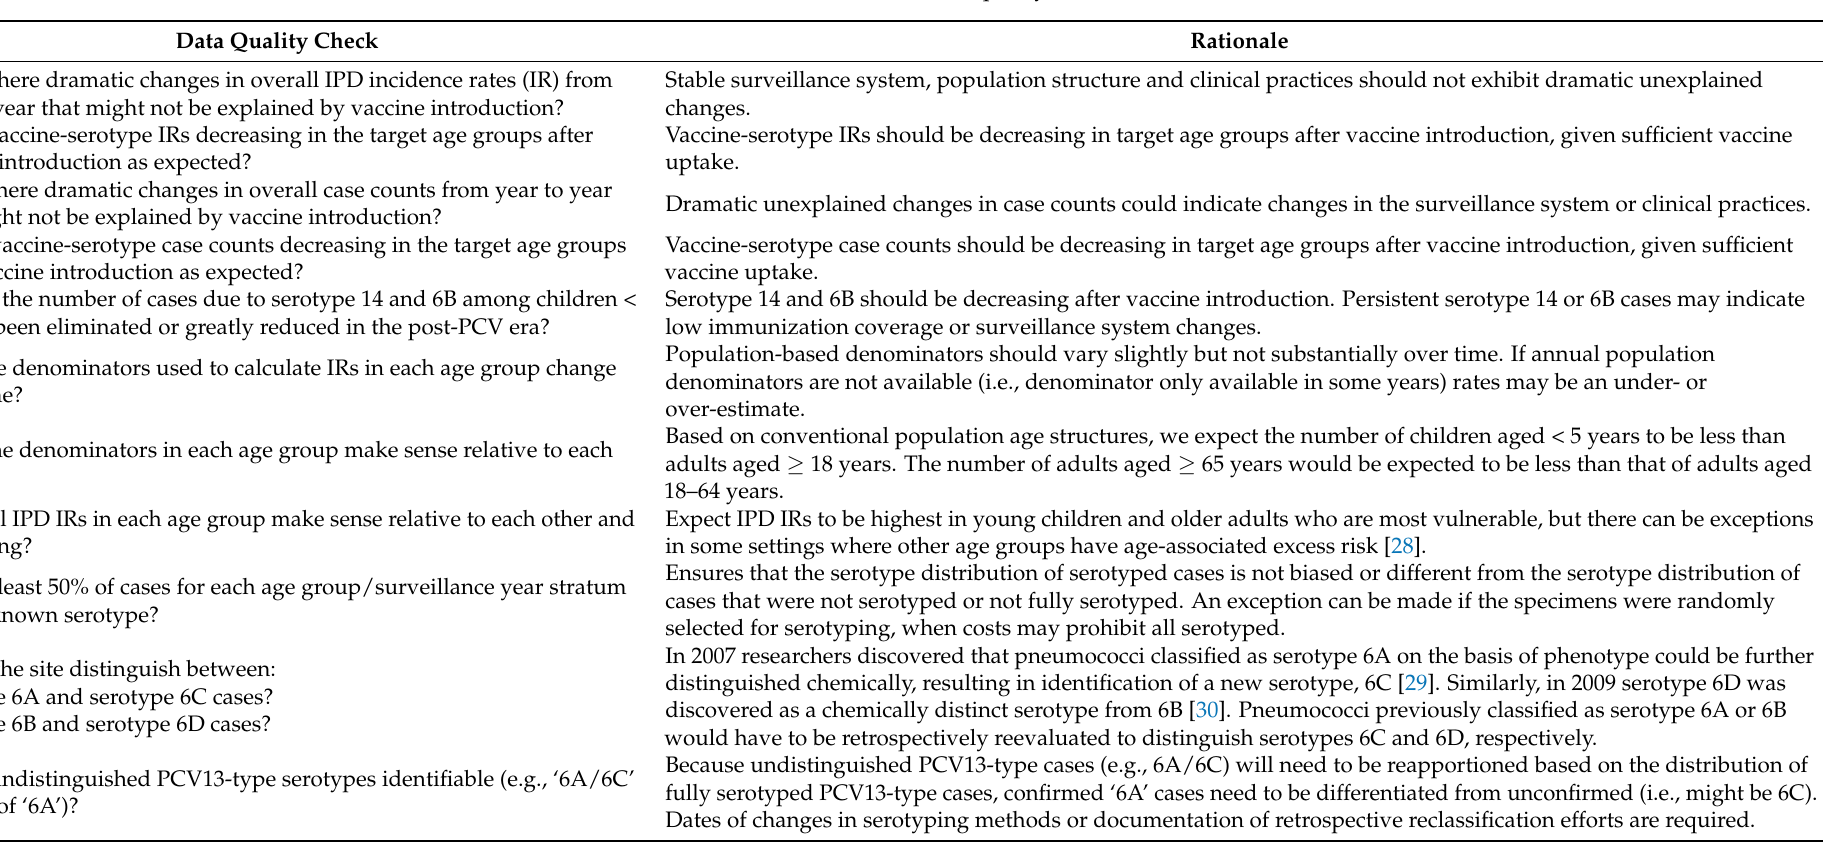
Table 2. PSERENADE standard data quality